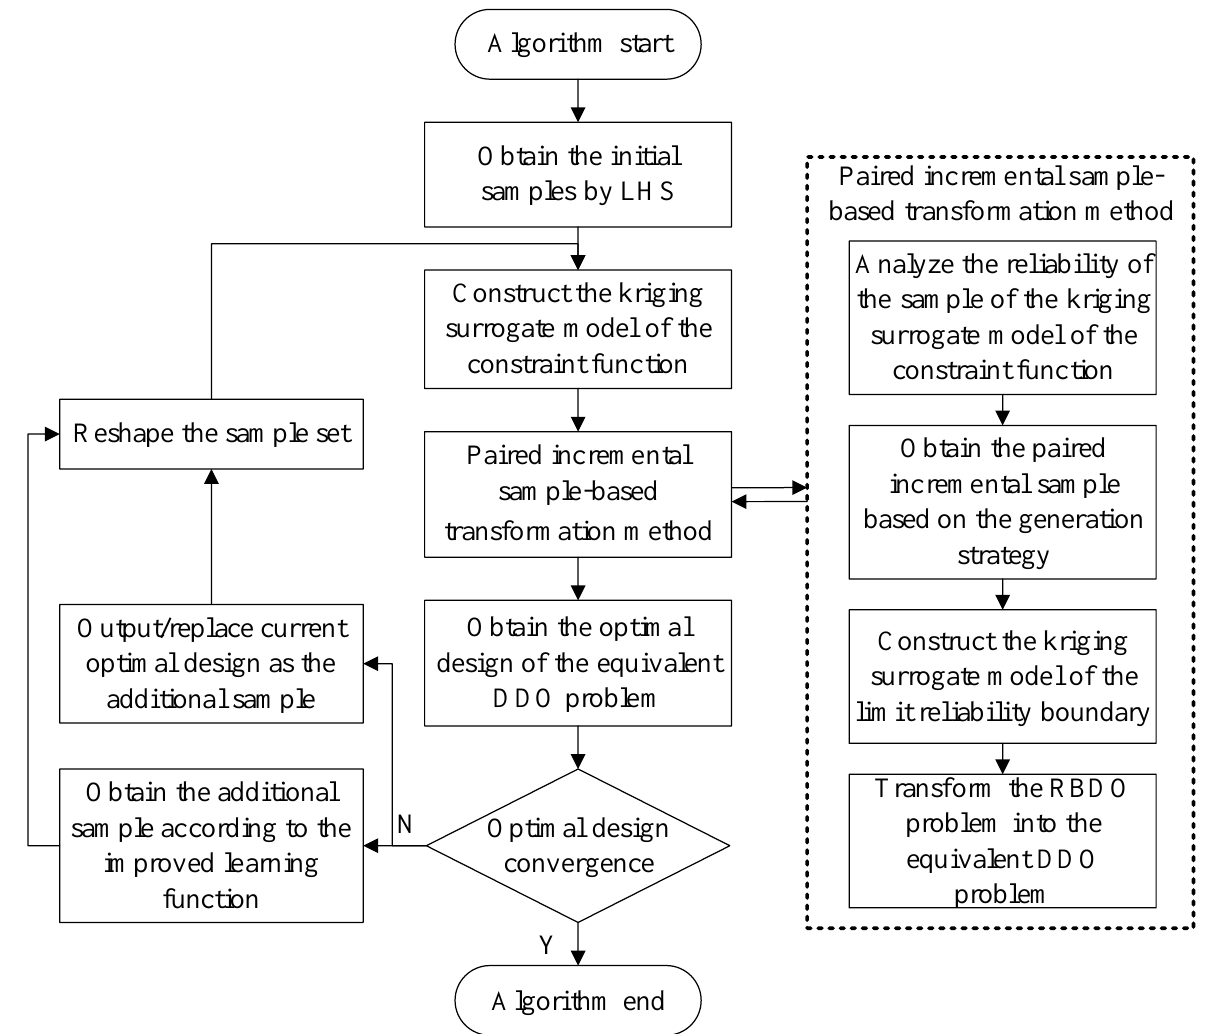
Figure 5. Algorithm diagram of the proposed method.